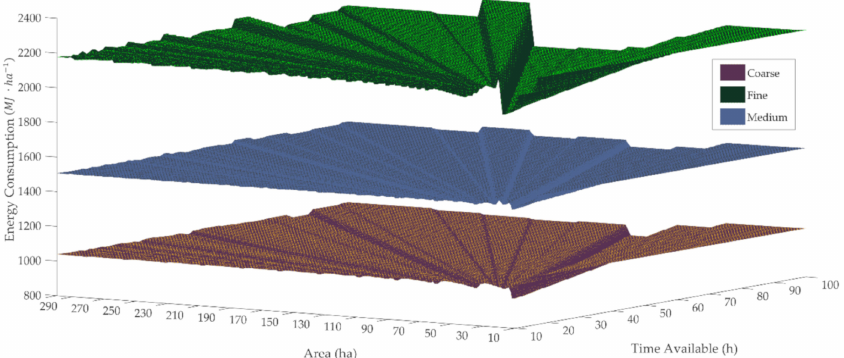
Figure 11. Moldboard plow energy consumption discrete model for various soil